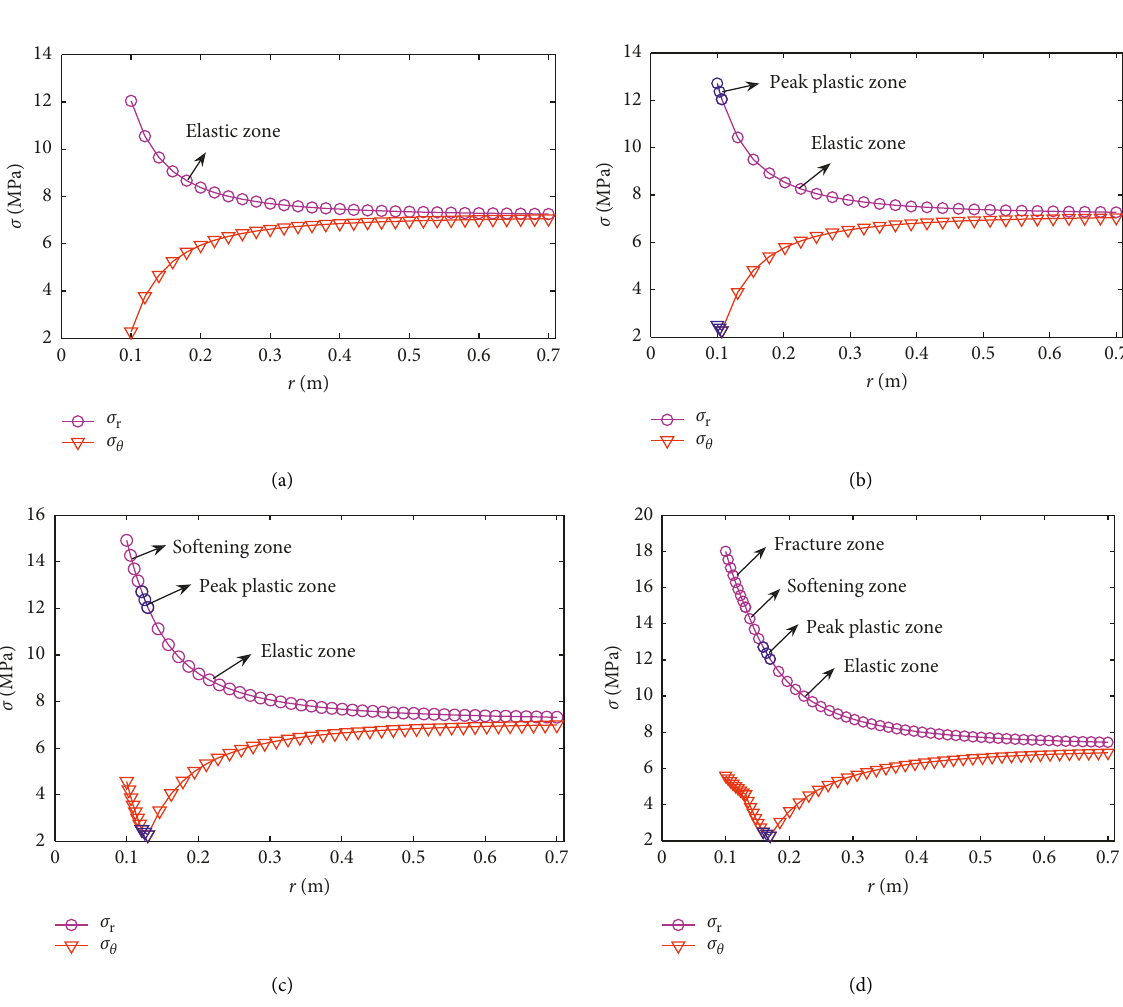
Figure 6: Stresses evolution law for the borehole